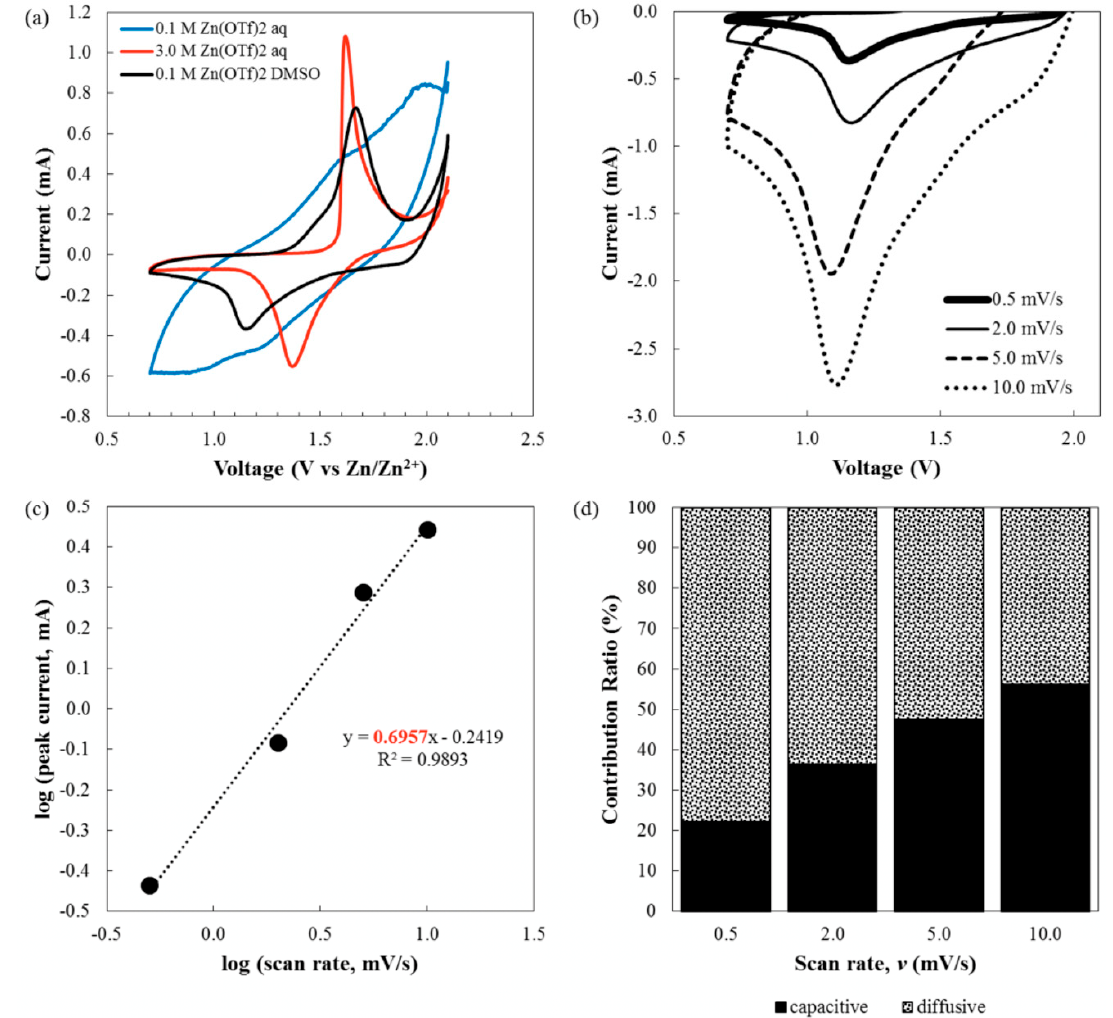
Figure 3. ( a ) Cyclic voltammograms of α -MnO 2 in 0.1 M aqueous Zn(OTf) 2 solution (blue), 3.0 M aqueous Zn(OTf) 2 solution (black) and 0.1 M nonaqueous Zn(OTf) 2 solution (red) at a scan rate of 0.5 mV/s, ( b ) cathodic peaks at different scan rates for α -MnO 2 with 0.1 M Zn(OTf) 2 in DMSO, ( c ) linear plot for determination of b value for α -MnO 2 with 0.1 M Zn(OTf) 2 in DMSO, and ( d ) histogram of capacitive and diffusive contribution for α -MnO 2 with 0.1 M Zn(OTf) 2 in DMSO at different scan rates.